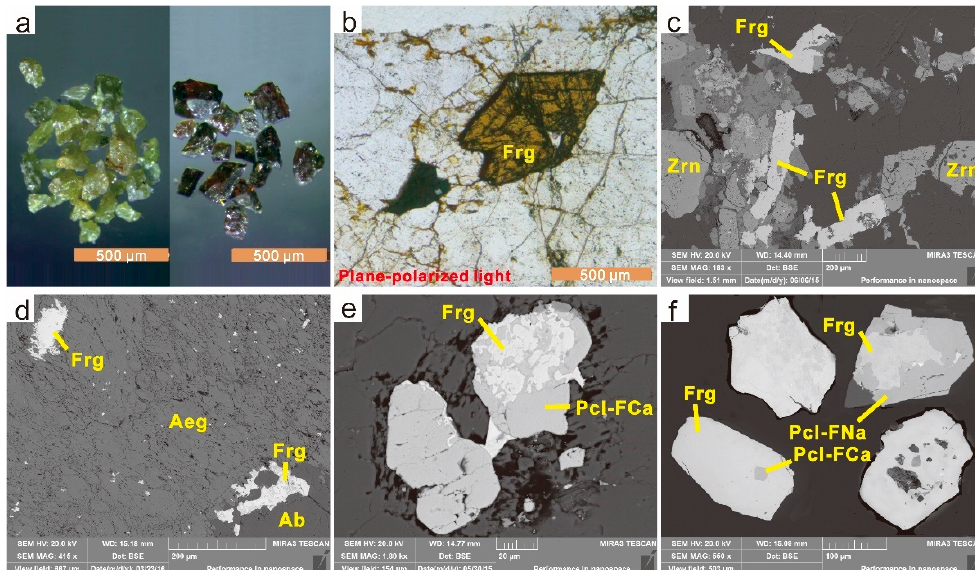
Figure 8. Photomicrographs and BSE images of fergusonite-(Y) with associated minerals. ( a ) Yellowish green and dark brown fergusonite-(Y) crystals; ( b ) photomicrographs of a euhedral fergusonite-(Y) crystal; ( c ) lath-like subhedral fergusonite-(Y) crystals (BSE); ( d ) disseminated anhedral fergusonite-(Y) (BSE); ( e ) disseminated fergusonite-(Y) associated with fluorcalciopyrochlore (BSE); and ( f ) disseminated fergusonite-(Y) associated with fluorcalciopyrochlore and fluornatropyrochlore (BSE). Abbreviations: Ab—albite; Aeg—aegirine; Frg—fergusonite-(Y); Pcl-FCa—fluorcalciopyrochlore; Pcl-FNa—fluornatropyrochlore; Thr—thorite; and Zrn—zircon.